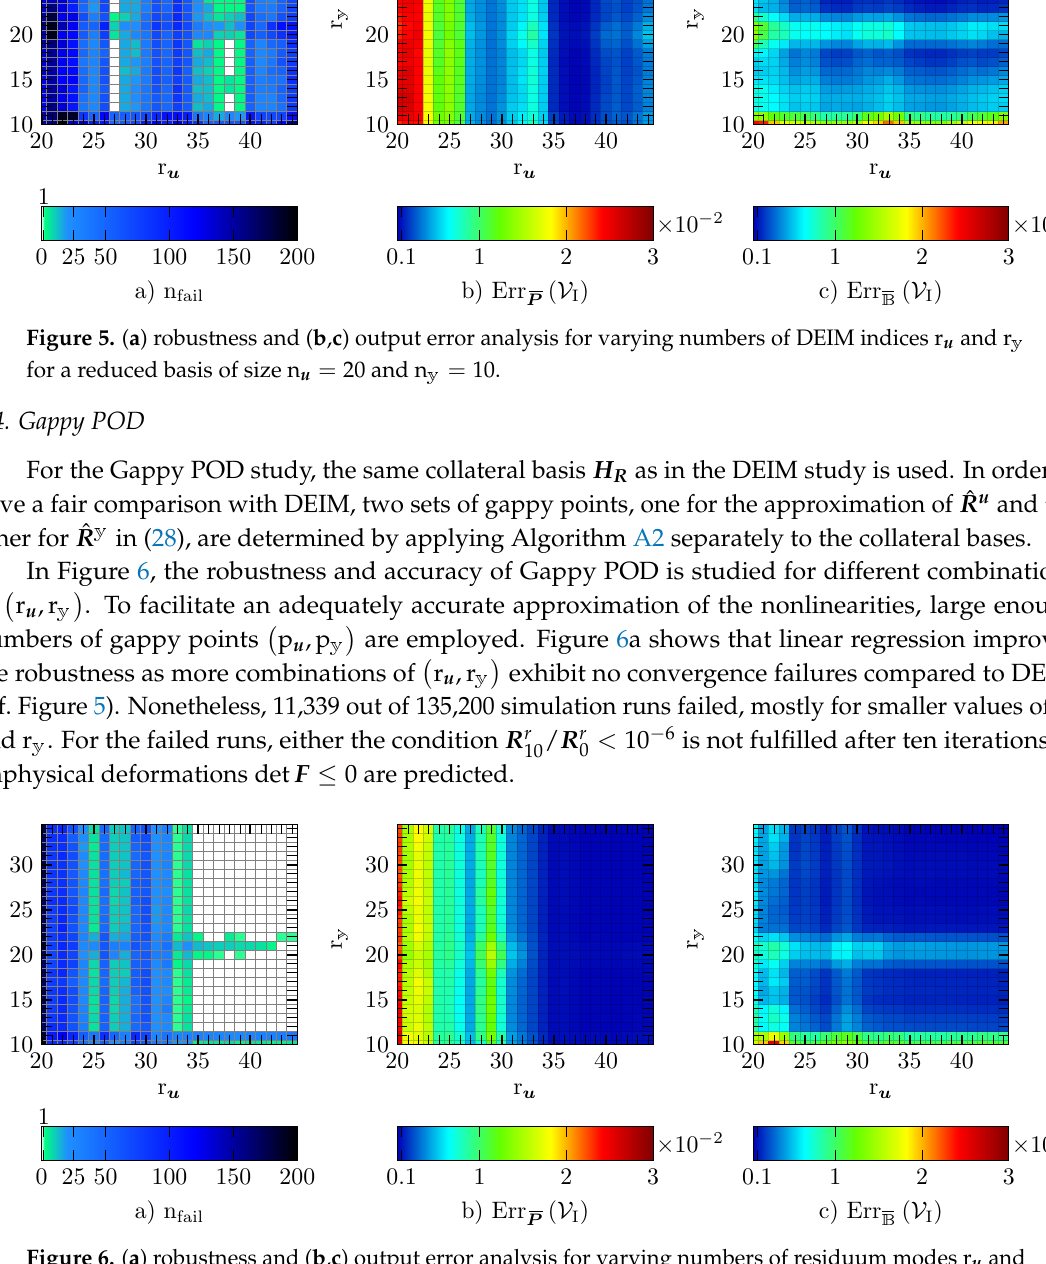
r u /2 + 10 and p y = r y + 20 for a reduced (cid:100) (cid:101)